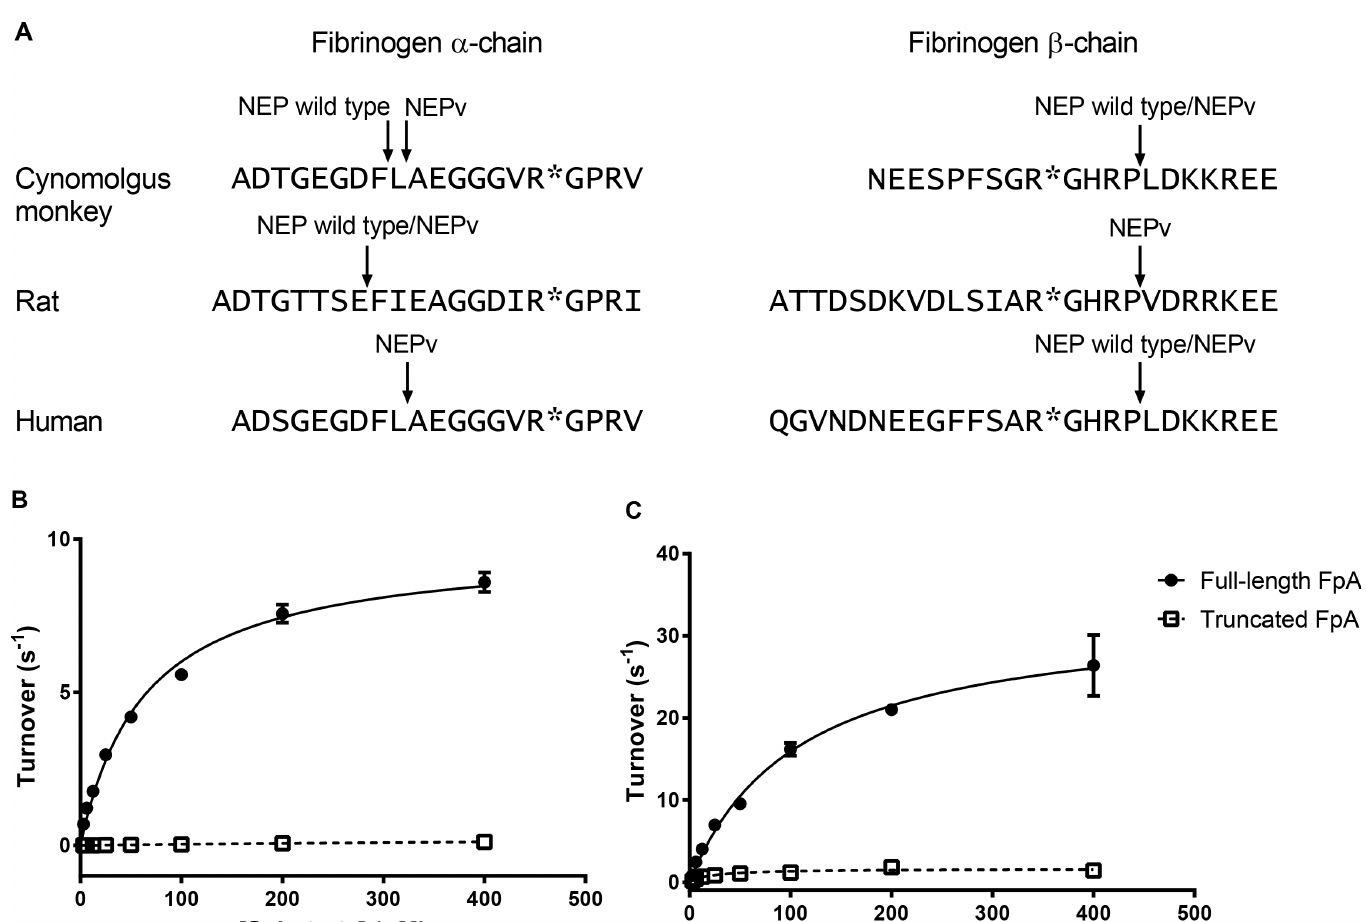
Fig 5. Cleavage sites of NEP wild type and NEPv in fibrinogen α - and β -chains and effect on FpA release by thrombin. Cleavage patterns for NEP wild type and NEPv on human, cynomolgus monkey and rat fibrinogen α - and β -chains were determined by N-terminal sequencing (A). Cleavage sites for NEP are indicated by arrows while those for thrombin are labelled * . Cleavage of full-length and truncated human or rat FpA by thrombin (B and C). Rates of cleavage were determined for full-length ( ● ) or NEP-truncated ( □ ) human (B) or rat (C) FpA by human or rat thrombin, respectively. The Michaelis-Menten equation was used to fit the data. Error bars represent SD (n = 3) and data are representative of two replicate experiments.